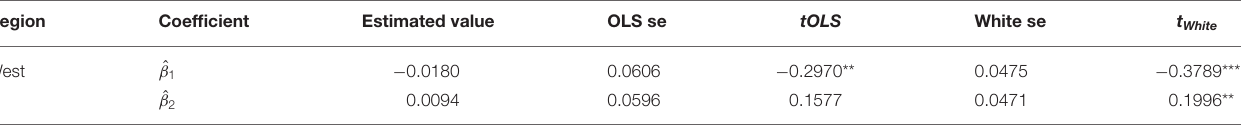
TABLE 6 | Estimated coefficients of air pollution and health care expenditure. Region Coefficient Estimated